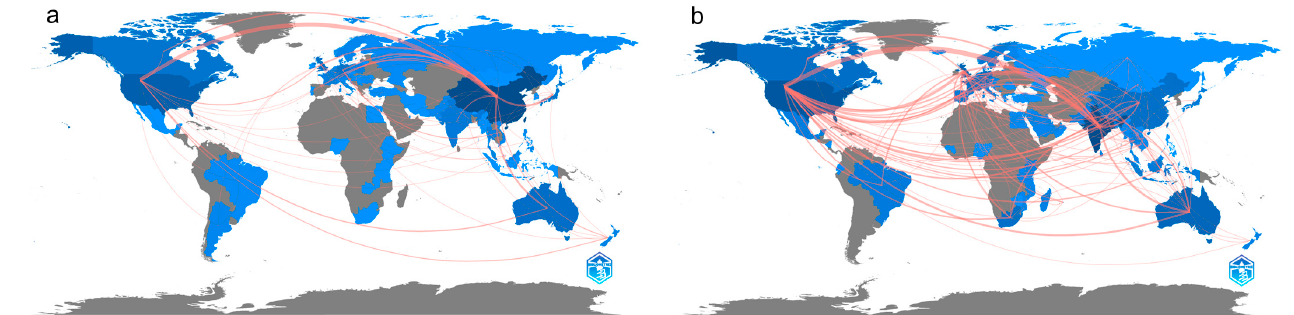
Figure 3. Geographical distribution of country/region collaboration in CPAP ( a ) and IPAP ( b ). The shaded colors indicate the volume of publications generated in the respective countries. The connections between countries reflect the cooperative relationship; thicker lines indicate further collaboration between countries.